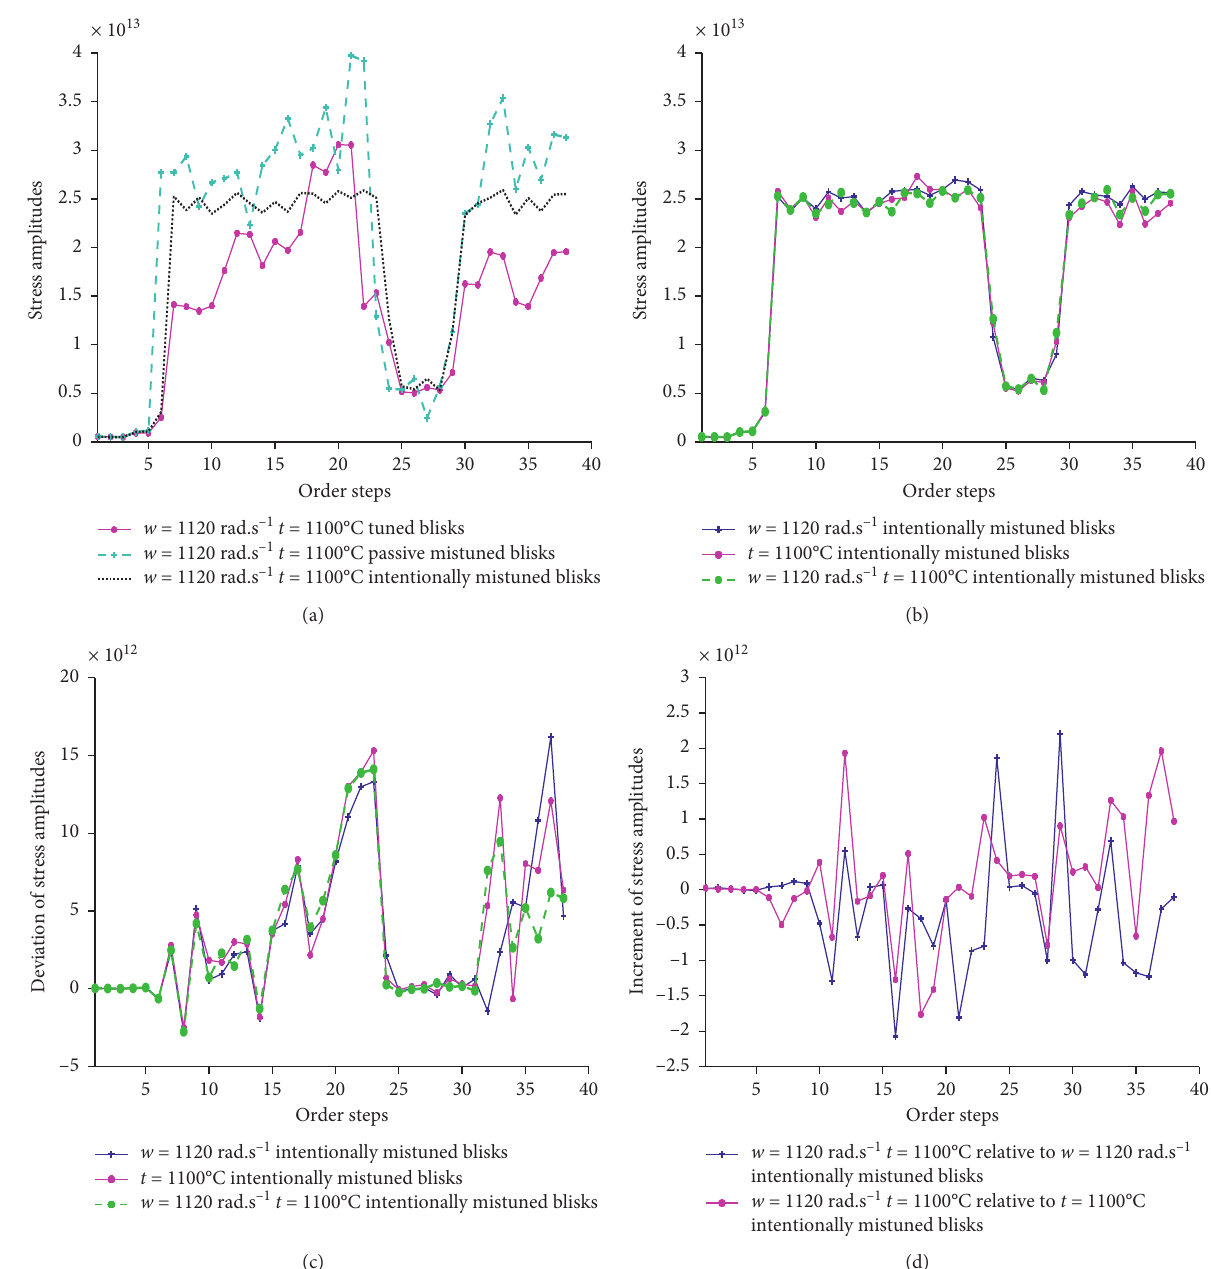
Figure 14: Stress amplitudes of intentionally MTB. (a) SAs of tuning, passive, and intentional mistuning. (b) SAs of intentional mistuning. (c) Deviation of SAs. (d) Increment of